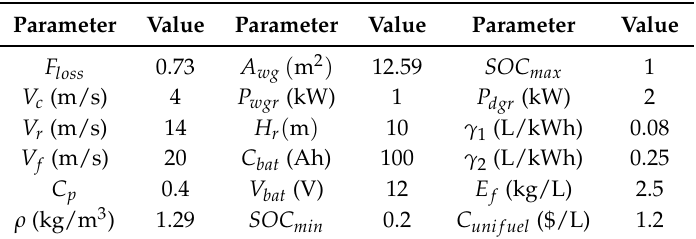
Table 2. Parameter specifications for the environment and the system